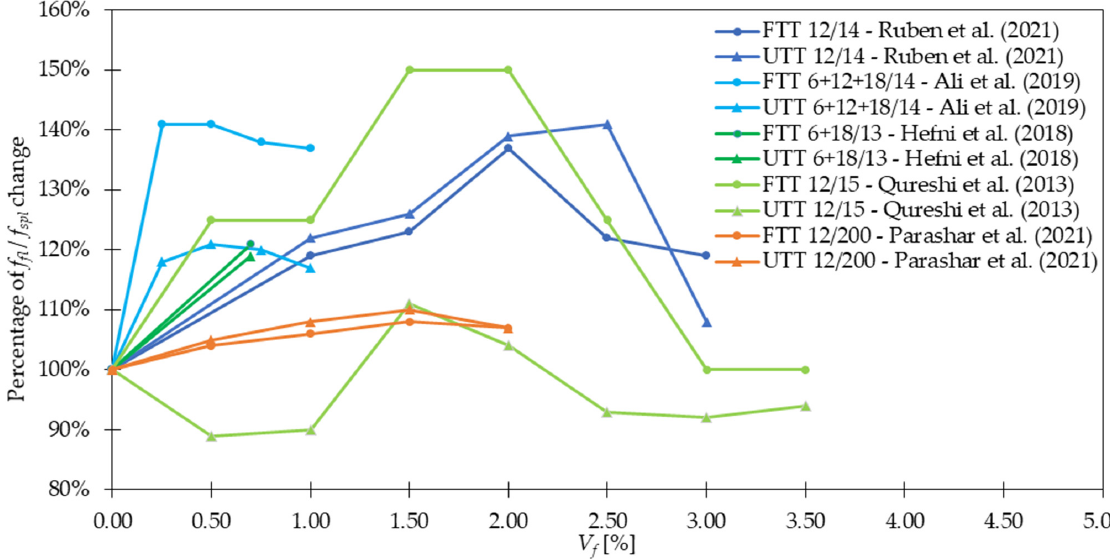
Figure 14. Change of f fl / f spl in relation to V f for different fiber geometry l f /d f [27,30,34,50,53].